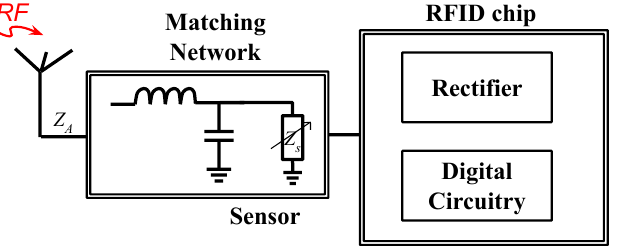
Figure 7. Block diagram of a chip-based antenna resonance wireless sensor.